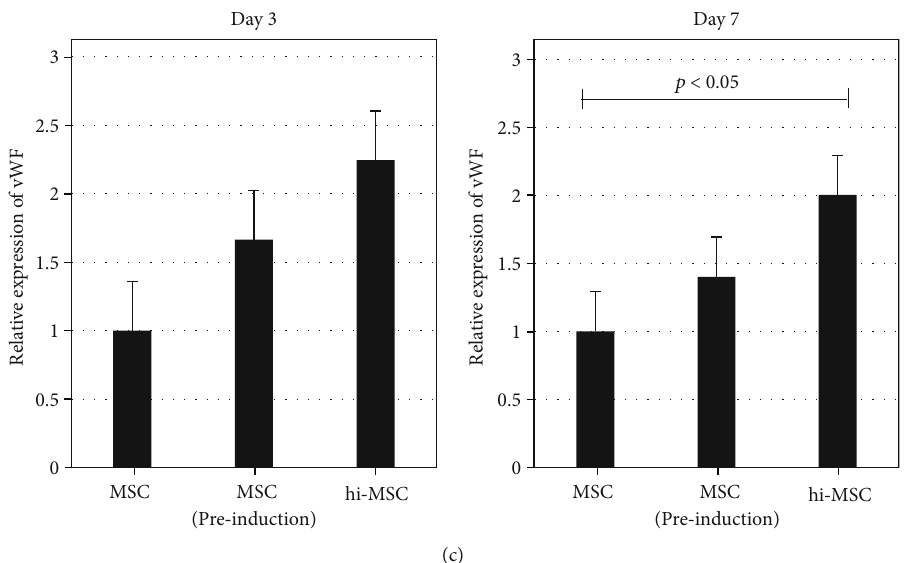
Figure 7: Endothelial cell (EC) di ff erentiation challenge of mesenchymal stem cells (MSCs) and hypoxia-induced MSCs (hi-MSCs) with analysis through TaqMan and SYBR Gene Expression Assays at day 3 and day 7 after cells were cultured with EC-induction medium. (a) Analysis of vascular endothelial growth factor (VEGF) gene expression. (b) Analysis of platelet endothelial cell adhesion molecule-1 (PECAM-1) gene expression. (c) Analysis of von Willebrand factor (vWF) gene expression. hi-MSC population of cells may have added potential for EC di ff erentiation compared to the MSC population of